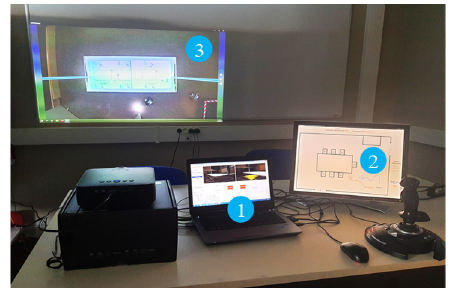
Figure 5. Logistics workplace (Organization 2). (1) Logistics control interface; (2) Tactical interface; (3) Bird’s eye view of the production cell.